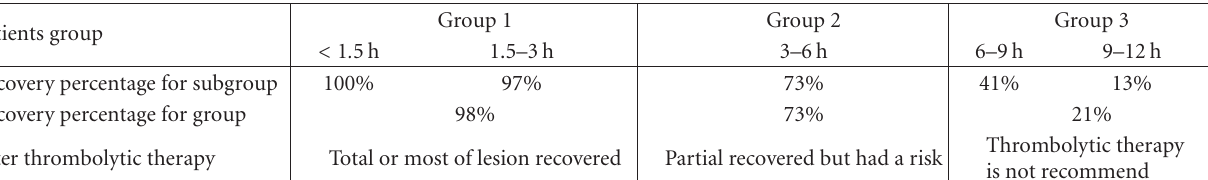
Table 2: The penumbra change and thrombolytic therapy.